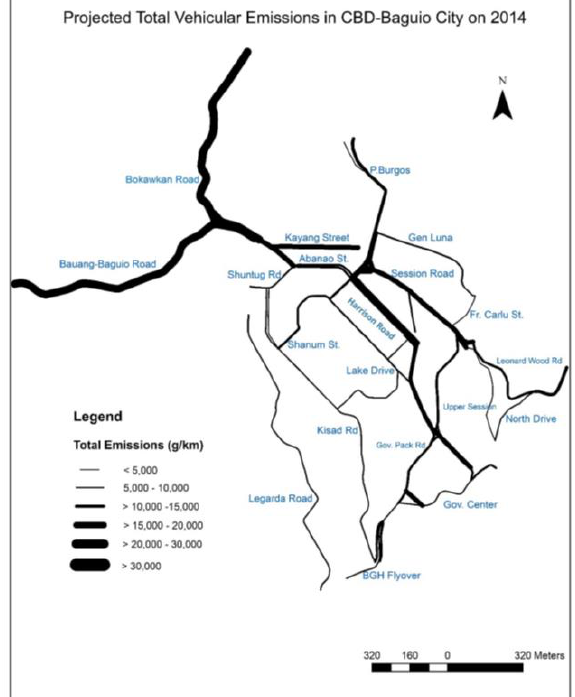
Figure 1. Total vehicular emissions on 2014 based on traffic projections and annual average daily traffic (AADT) in 2016 The PM measurements recorded at the Burnham Park station are for fine particulates (PM 2.5 ) and coarse particulates (PM 10 ). These particulates mainly differ on the size or diameter and